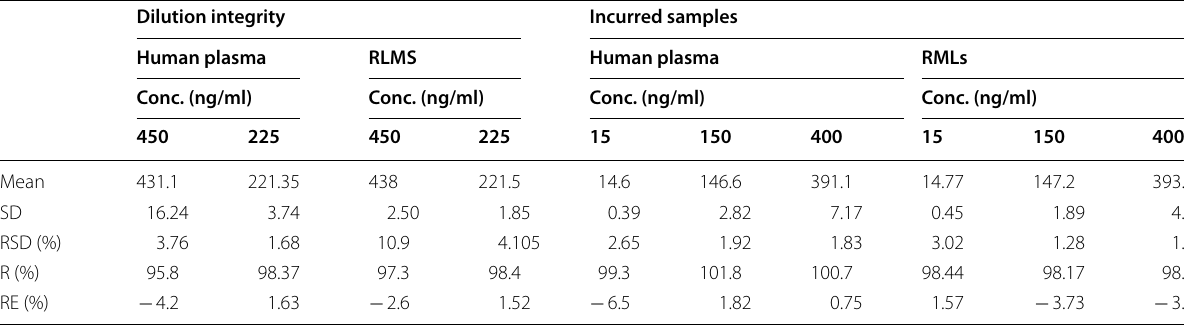
Table 3 Dilution integrity and incurred samples